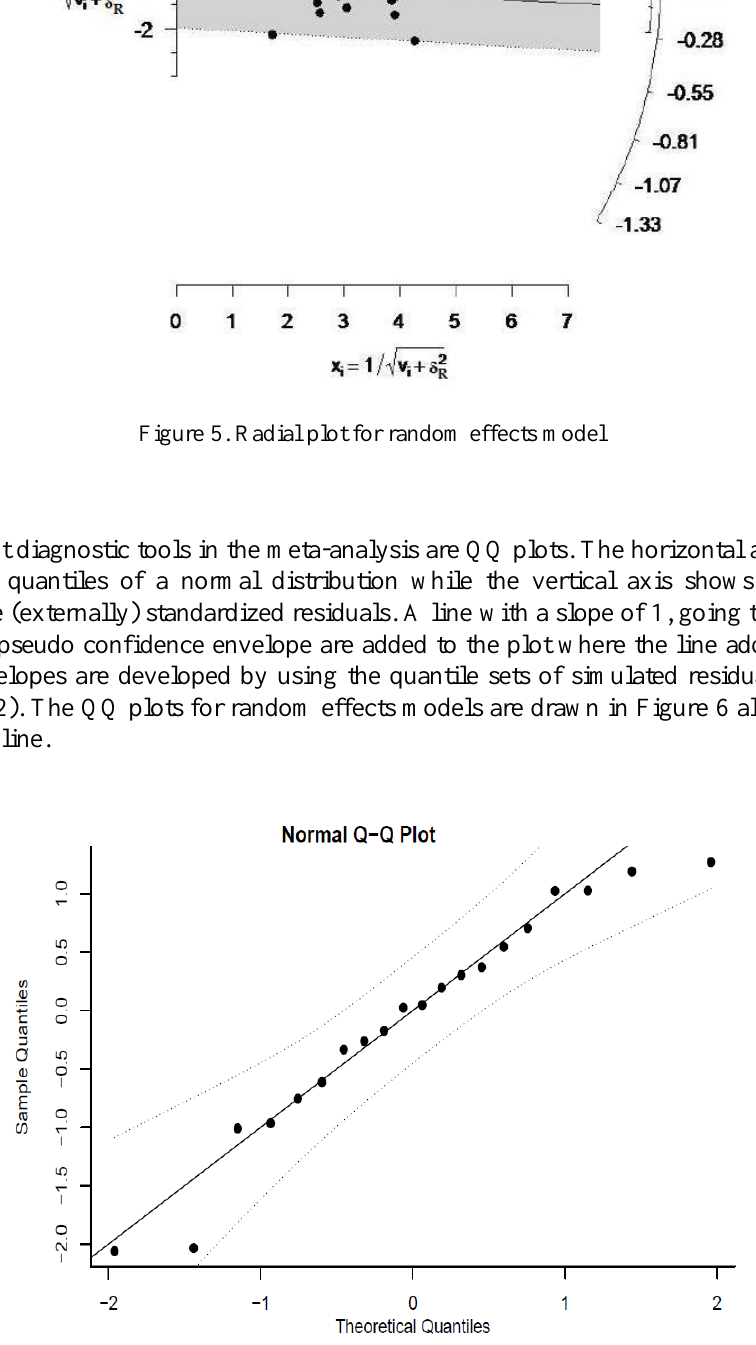
Figure 6. QQ plot for random effects